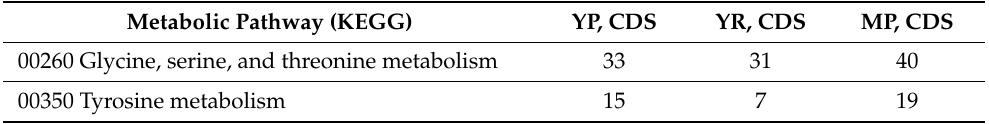
Table 7. Metabolic pathways represented by more CDS in M. primoryensis KMM3633 T compared to the studied Yersinia